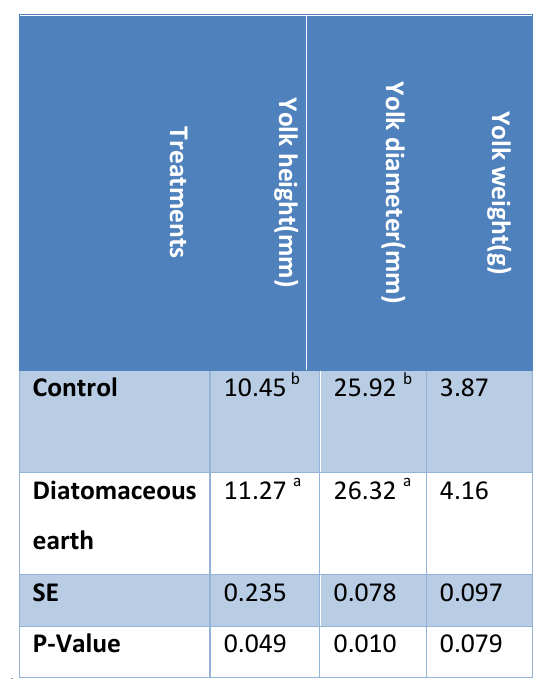
Table, 4: Evaluation of diatomaceous earth on egg yolk characteristics in quail